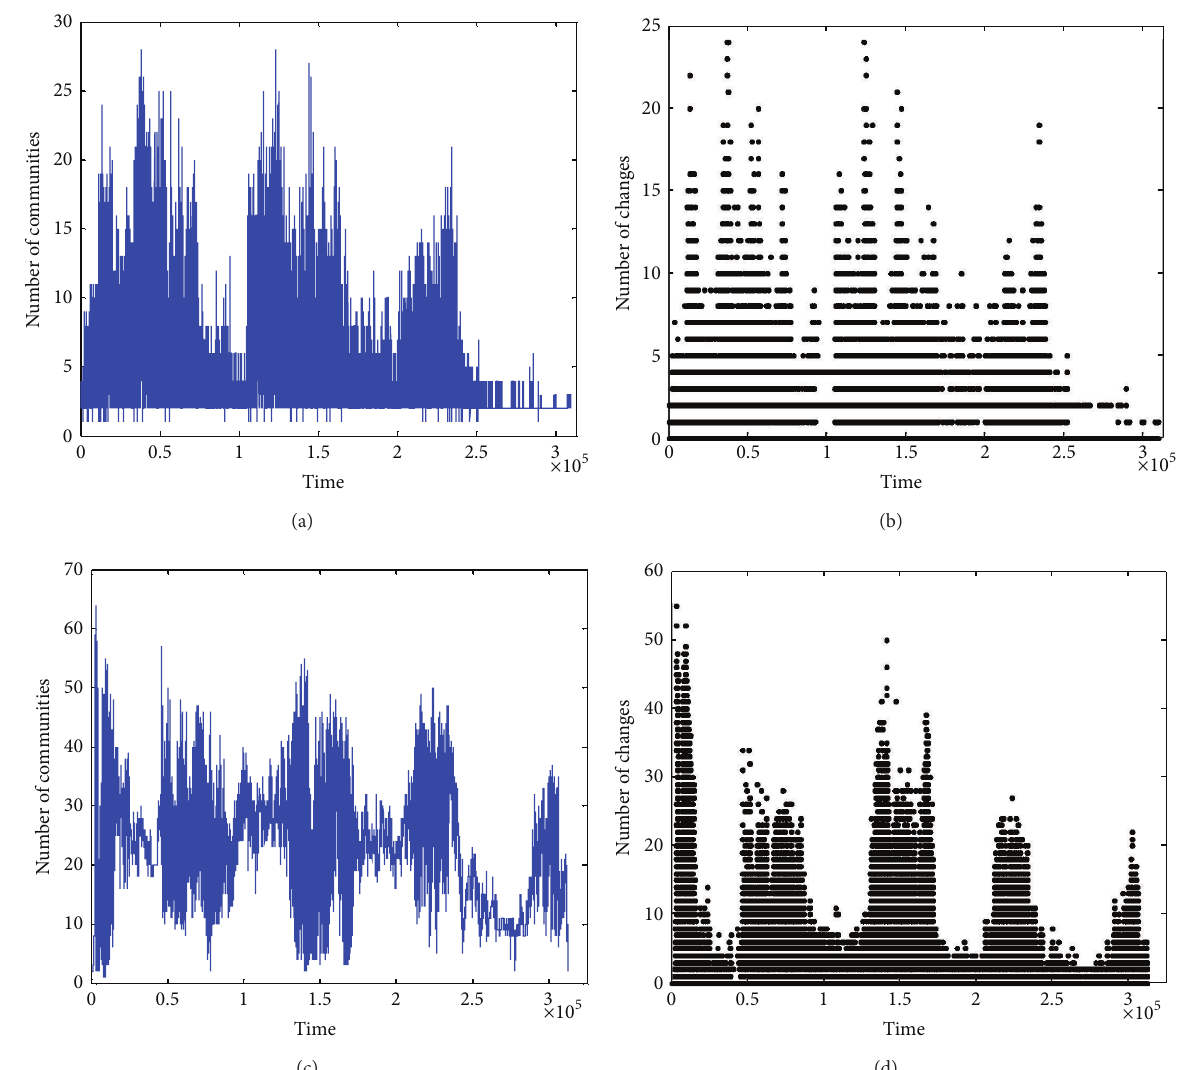
Figure 12: Number of communities detected by COPRA. (a) Number of communities at each timestamp (SIGCOMM09). (b) Number of community changes between two consecutive timestamps (SIGCOMM09). (c) Number of communities at each timestamp (INFOCOM06). (d) Number of community changes between two consecutive timestamps